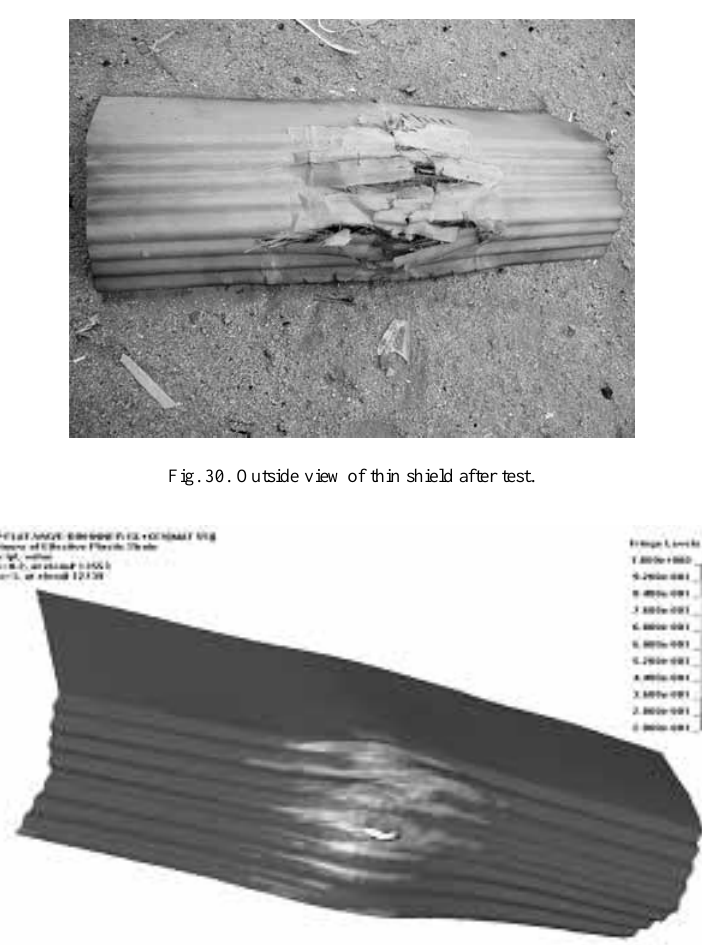
Fig. 31. Basic shield damage by blast simulated by the revised model (inside